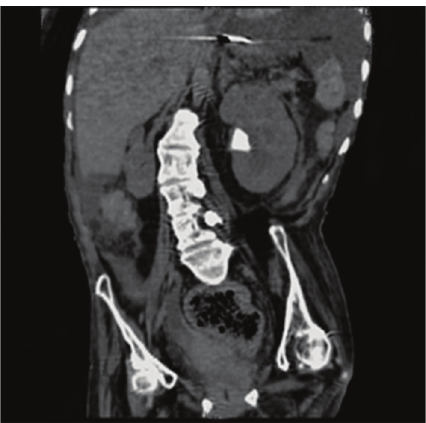
Figure 1: 7mm obstructing left PUJ calculus.